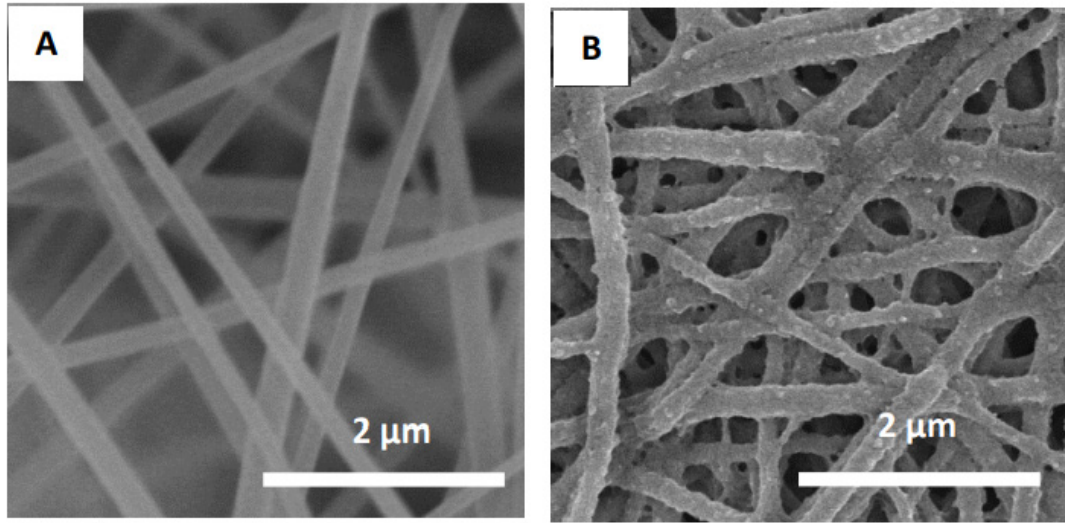
Figure 4. Scanning electron microscopy (SEM) images of native cellulose nanofibers ( A ), and HEMA/CNF copolymer nanofibers ( B ).